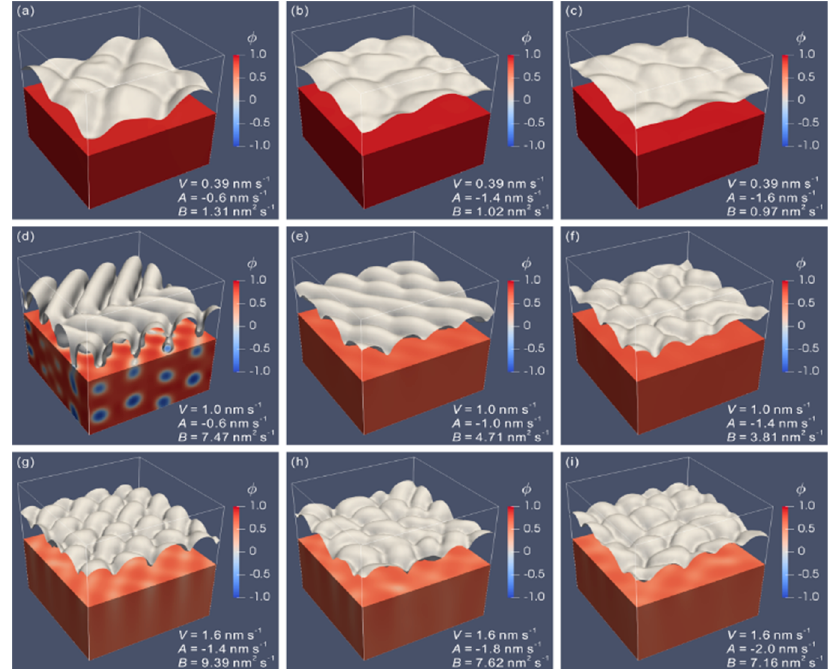
Figure 1. Typical microstructures due to the 3D phase-field simulations performed in a domain with 48 × 48 × 48 nm 3 for thin films deposited with three di ff erent deposition rates (denoted as V ) corresponding to the di ff erent gas-solid transition velocities (denoted as A ) and incident vapor rates (denoted as B ) at the deposition time of 10 min: ( a ) V = 0.39 nm s − 1 , A = − 0.6 nm s − 1 and B = 1.32 nm 2 s − 1 ,